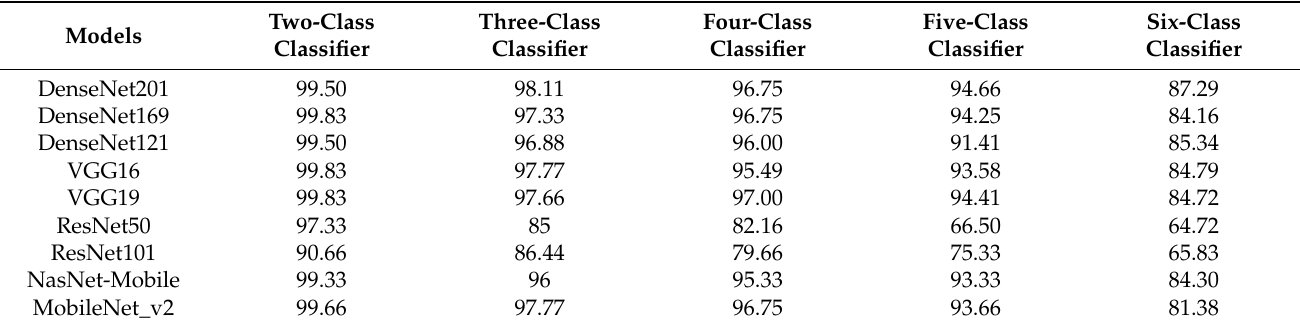
Table 14. Accuracy (%) of the proposed model for different classes using different deep learning networks.